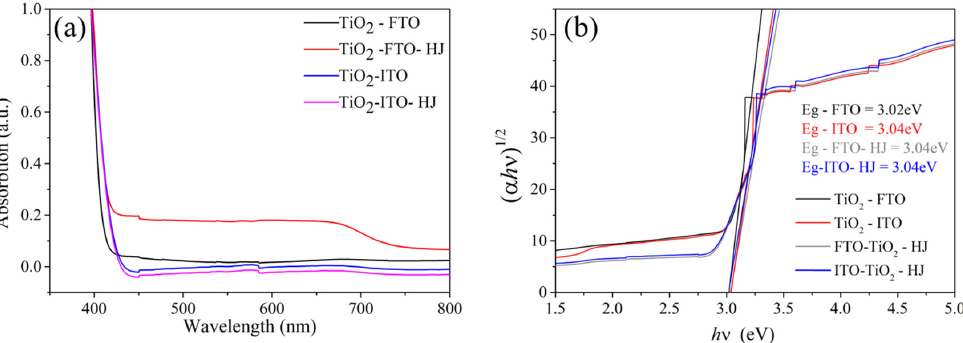
Figure 9. UV-Vis absorption spectrum and band gap calculation diagram of TiO 2 nanoarrays: ( a ) Ultraviolet-visible absorption spectrum; ( b ) Band gap calculation chart.